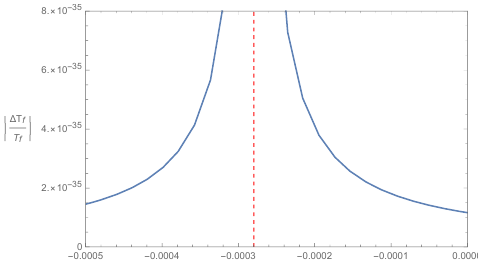
Figure 3. | ∆ T f / T f | vs. the model parameter n (blue solid curve), for Model V: f = − T + (cid:0) (cid:1) n T 2 + β 2 T G α ln β 1 , choosing β 1 = 0.001 GeV − 4 n , β 2 ≈ − 2.7. The vertical dashed line at n − 0.0003 denotes the point where (37)